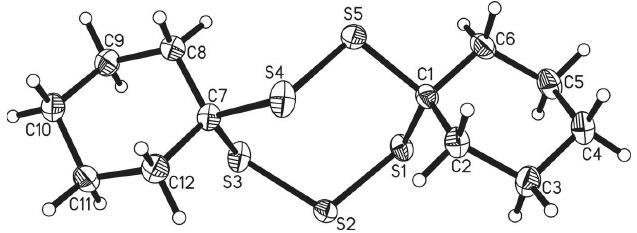
Figure 1 The molecular structure of 7,8,15,16,17-pentathiadispiro[5.2.5 9 .3 6 ]hepta- decane. Ellipsoids are shown at the 50%